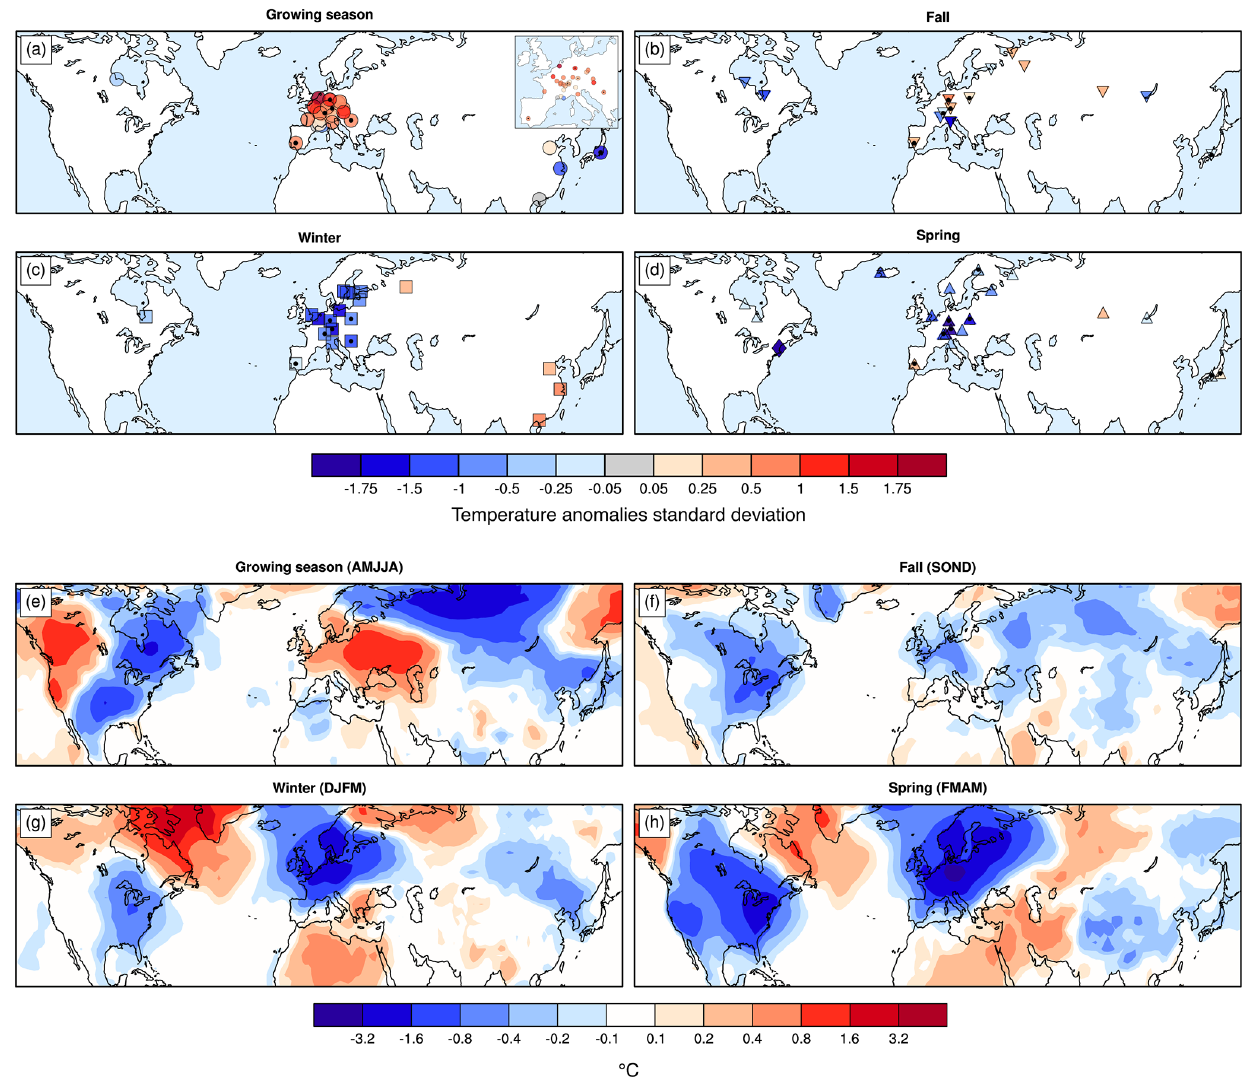
Figure 4. Temperature composites of documentary series for the Laki eruption 1783–1784CE. Proxy series are categorized seasonally: (a) growing season proxies for 1783CE, (b) fall proxies for 1783–1784CE, (c) winter proxies for 1784–1785CE, and (d) spring proxies for 1784–1785CE. Composites that are very close to 0 are colored grey (regardless of their sign). Panels (e) through (h) show composites of 2m surface air temperature during the corresponding seasons based on the EKF400v2.0 reanalysis. Documentary proxies assimilated in the EKF400v2 are indicated by a black dot in (a) through (d)